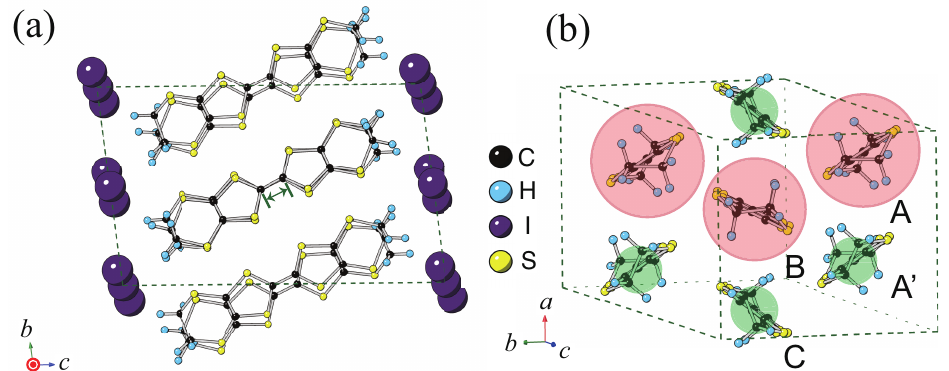
Figure 1. Crystal structure of α -(BEDT-TTF 2 )I 3 at 30 K [29]. The unit cell is shown by the dashed lines. ( a ) A view along the a -axis; ( b ) ET molecules in the ab -plane, where four independent molecules, A, A (cid:48) , B, and C, are shown. The shaded circles schematically show the charge order, whose diameters are drawn to be proportional to the estimated charge values of the molecules in [16]: A = +0.82, A (cid:48) = +0.29, B = +0.73, and C =